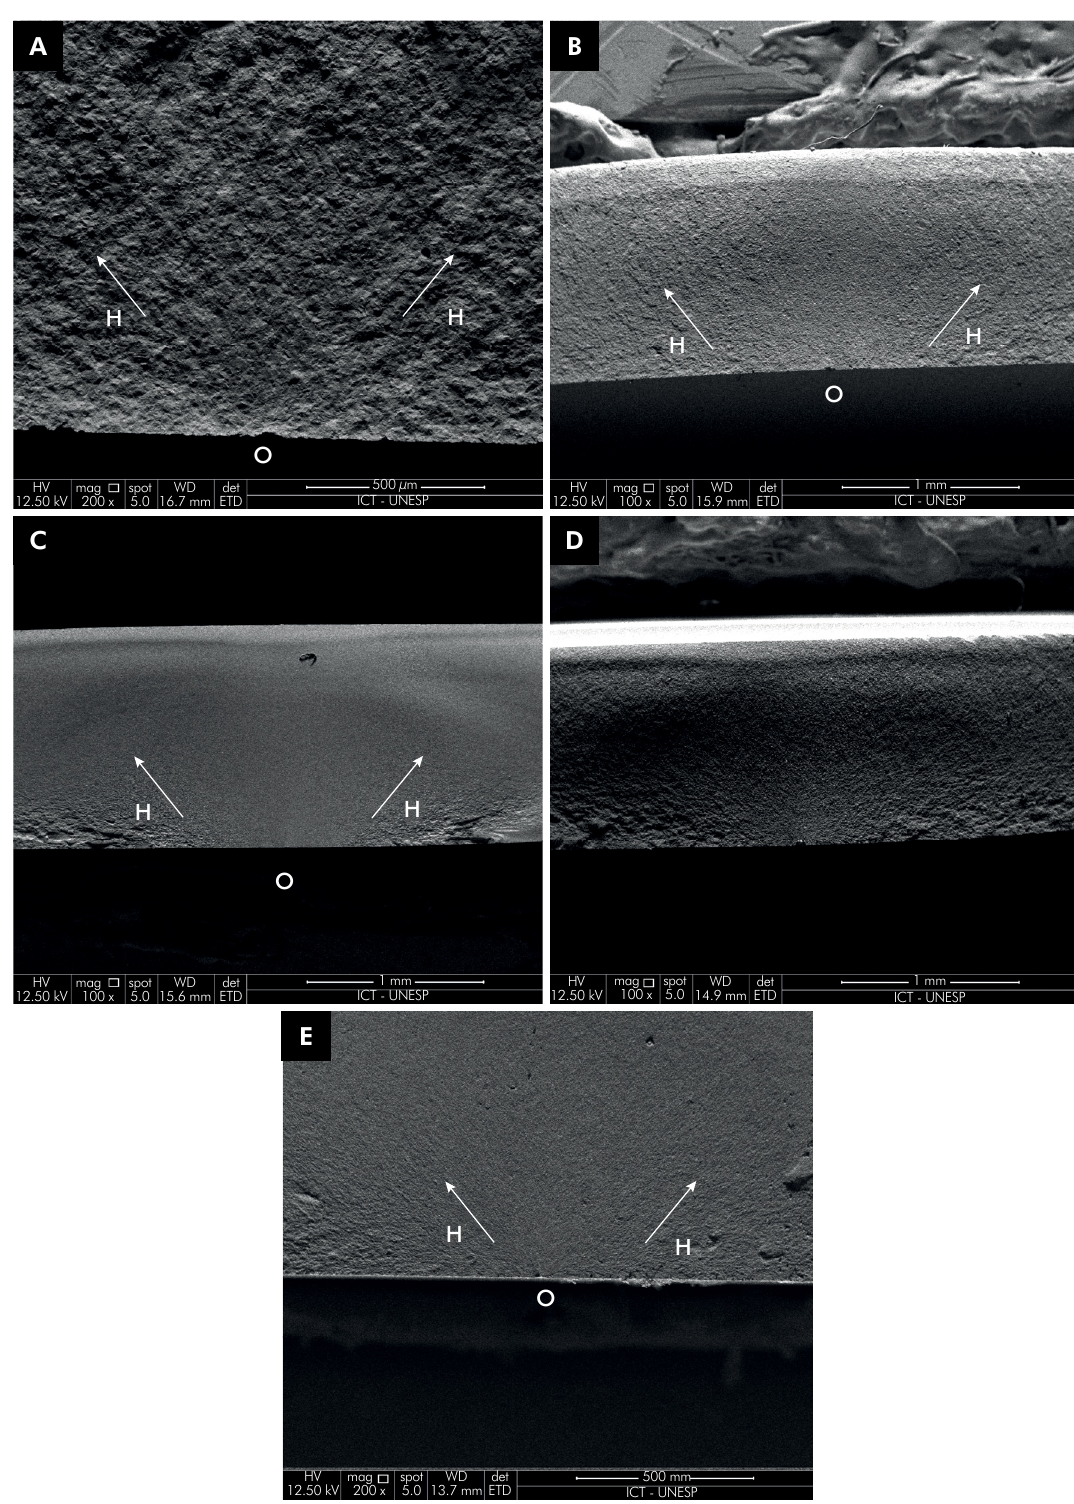
Figure 2. Representative scanning electron microscopy images of the fractured discs subjected to fatigue test: (A) feldspathic ceramic, (B) polymer-infiltrated ceramic network, (C) zirconia-reinforced lithium silicate glass-ceramic, (D) lithium disilicate glass-ceramic, and (E) yttrium partially stabilized tetragonal zirconia polycrystals. The arrows indicate the direction of crack propagation. The crack origins (O), mainly semi-elliptical flaws on the surface, and the surrounding hackle lines (H) are also